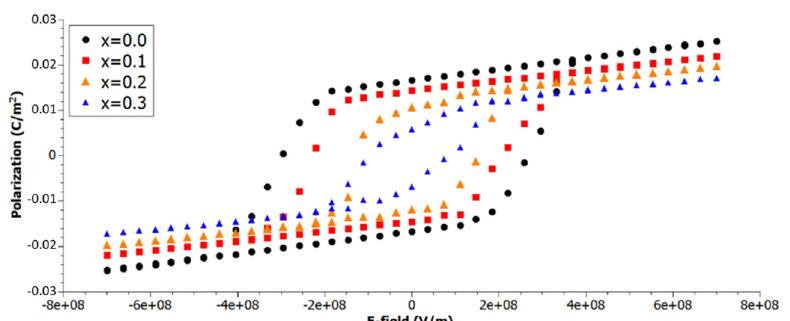
Figure 1. P(E) loops of Ba(Ti 1 − x Zr x )O 3 at different concentrations x of Zr. The temperature during the simulation was fixed at 200 K, whereby the number of MC-sweeps per E-field step was set to 2000. The Zr atoms were randomly distributed on a two-dimensional grid of size 16 ×